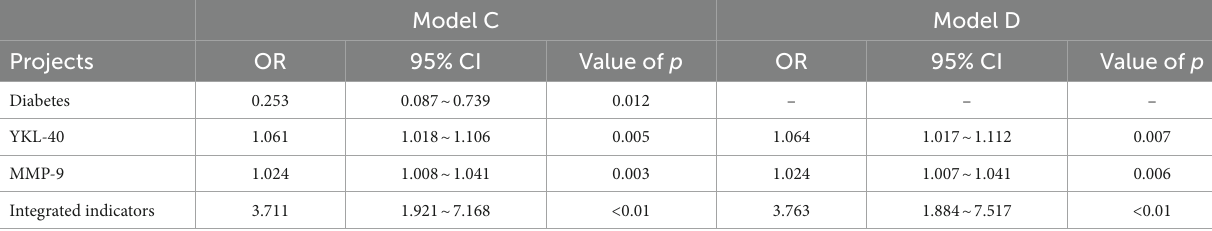
TABLE 5 Binary logistic regression analysis of risk factors for posterior circulation positive